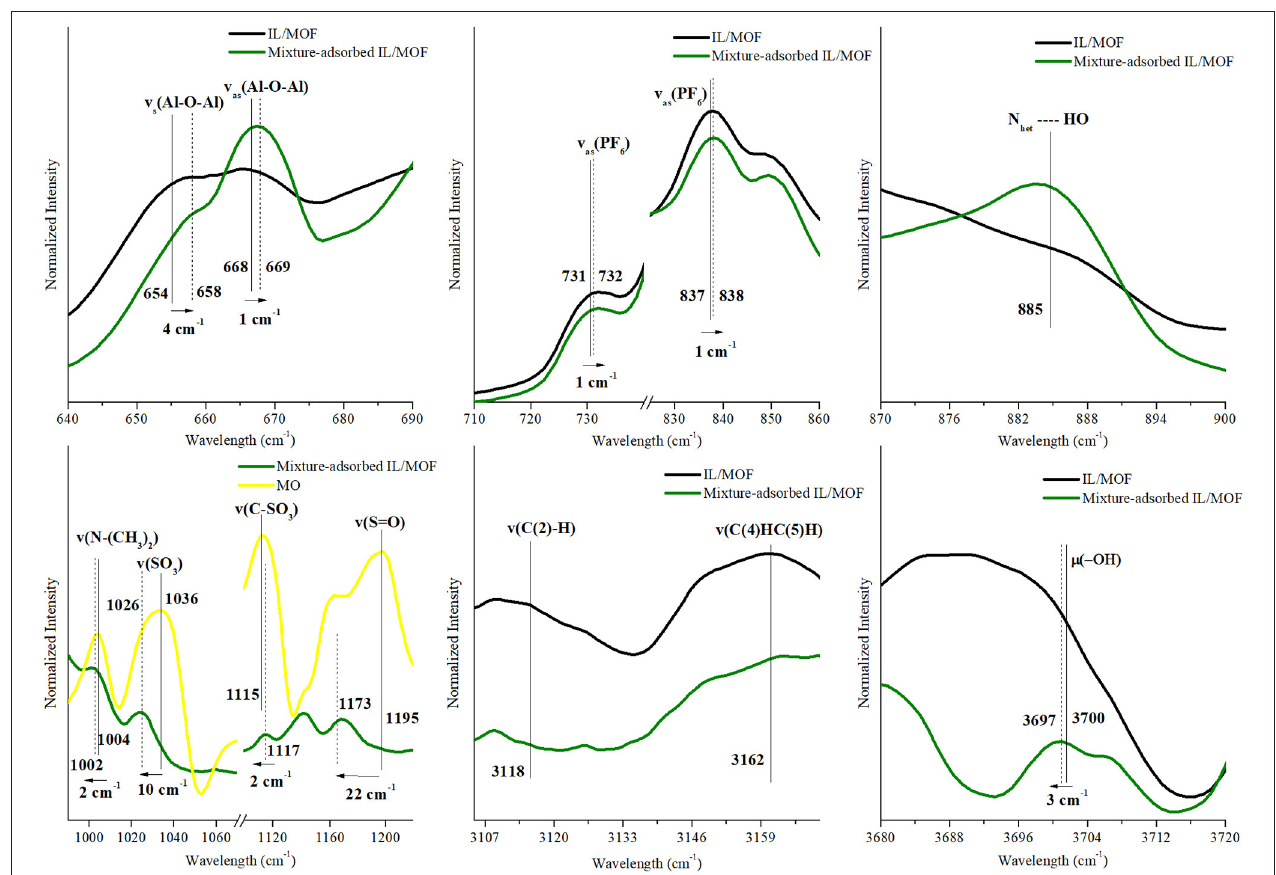
FIGURE 9 | Changes in the characteristic FTIR peaks of [BMIM][PF 6 ]/MIL-53(Al) composite, MB, and MO after the adsorption of MB–MO mixture. FTIR, Fourier transform infrared; MB, methylene blue; MO, methyl orange.